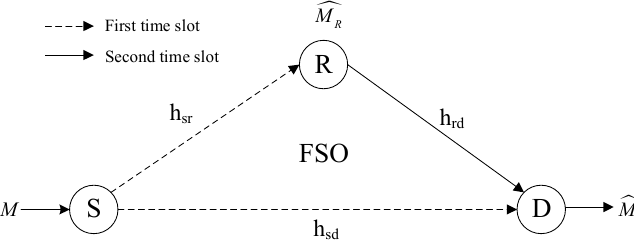
Figure 1. Basic system block diagram of cooperative communication system. In half-duplex mode, each node sends and receives signals at different time slots. In this system, the system polarization code is only used to encode the information bits of the original information M . Assuming that the information sequence encoded by the source node is x s , during the first time slot of the FSO cooperative communication system, the source node S sends signals to the relay node R and the destination node D ,